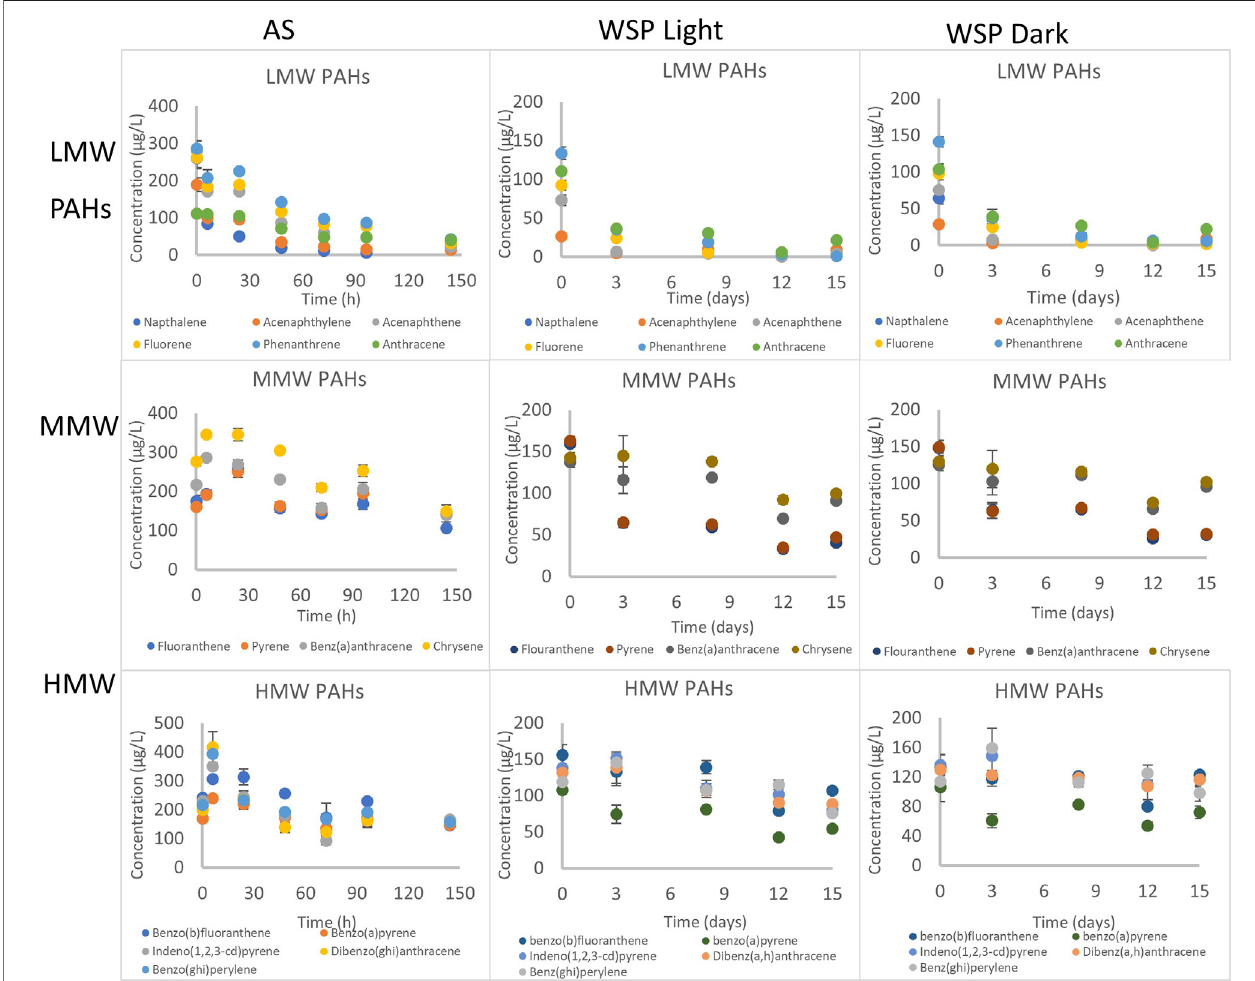
FIGURE 2 | Disappearance of PAHs under aerobic conditions with activated sludge and facultative inocula (under light and dark conditions). Concentration determined in the combined phase (dissolved and particulate). AS refers to activated sludge, WSP refers to waste stabilization ponds. LMW, MMW and HMW refers to low molecular weight, middle molecular weight and high molecular weight